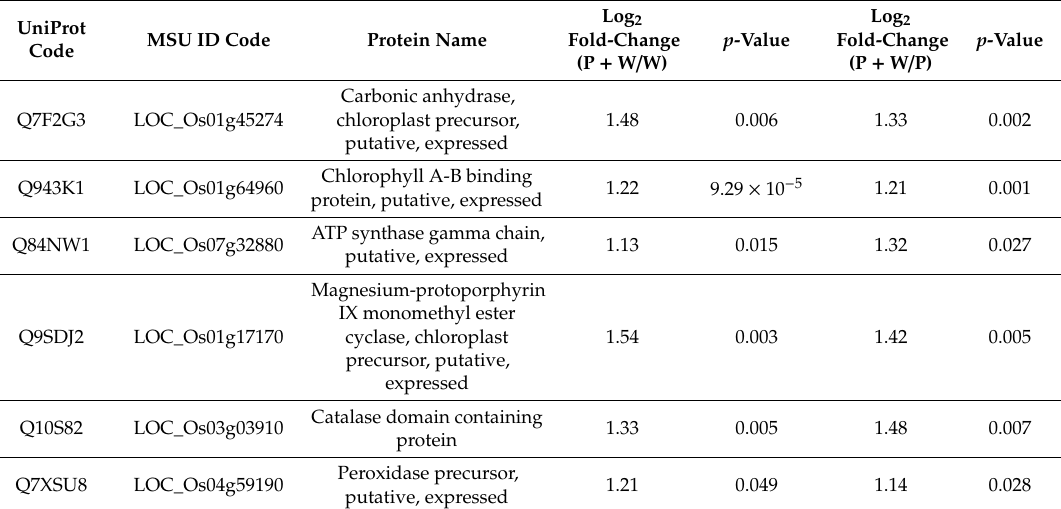
Table 4. Priming-regulated proteins. Log2 fold-change after MeJA + wounding, compared to wounding (P + W / W), log 2 fold-change after MeJA + wounding, compared to MeJA (P + W / P) and corresponding p-values are